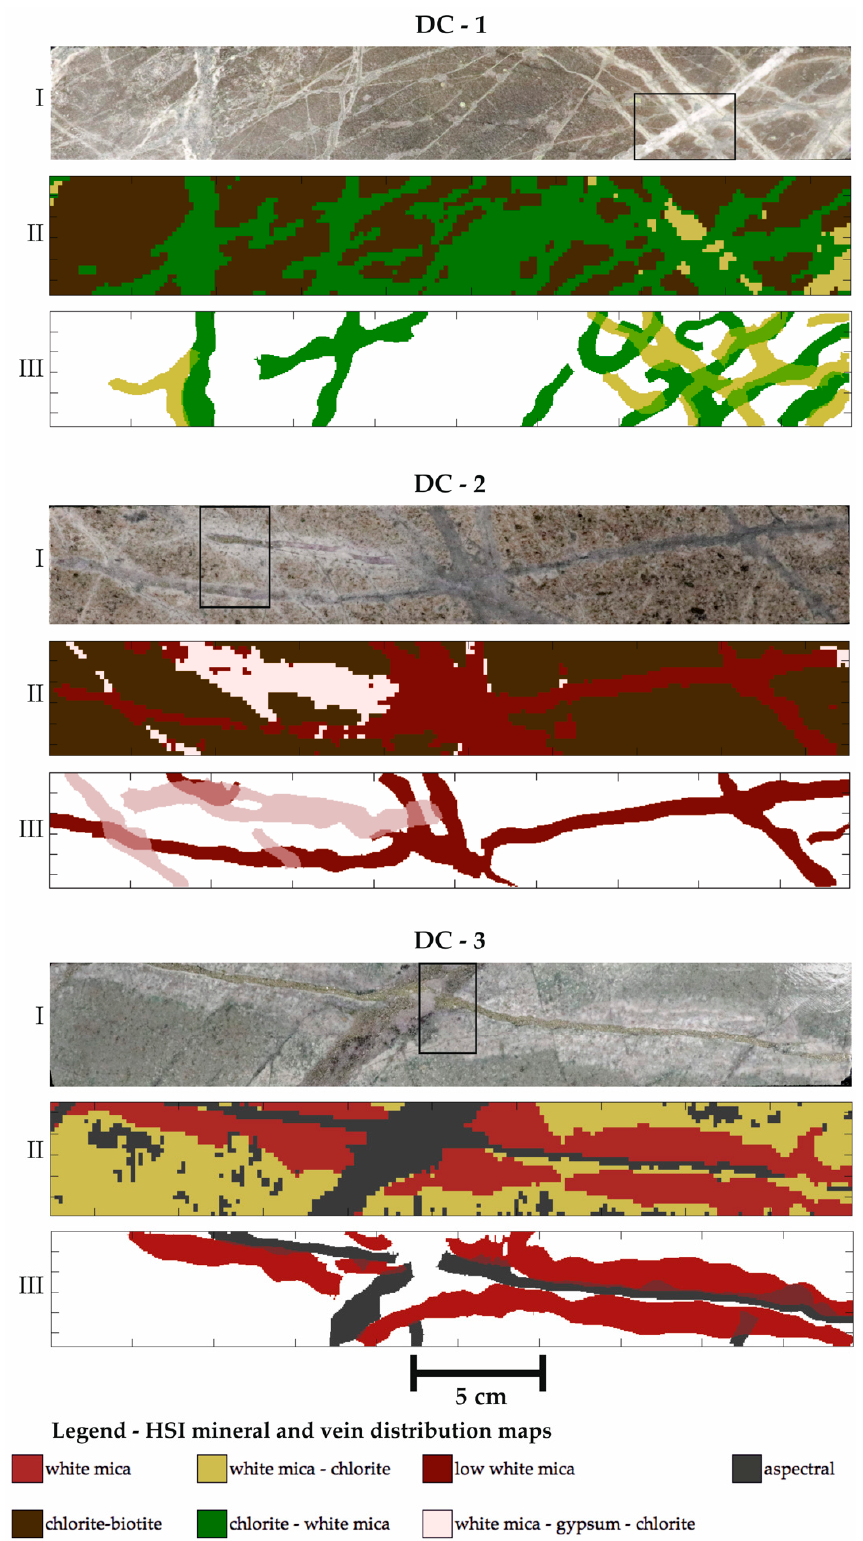
Figure 10. Illustrative diagram of data validation for each of the three samples. I = RGB image of the drill cores with marked area of the location of the SEM-MLA mineral map, II = HSI-based maximum abundance mineral map, III = vein distribution maps.